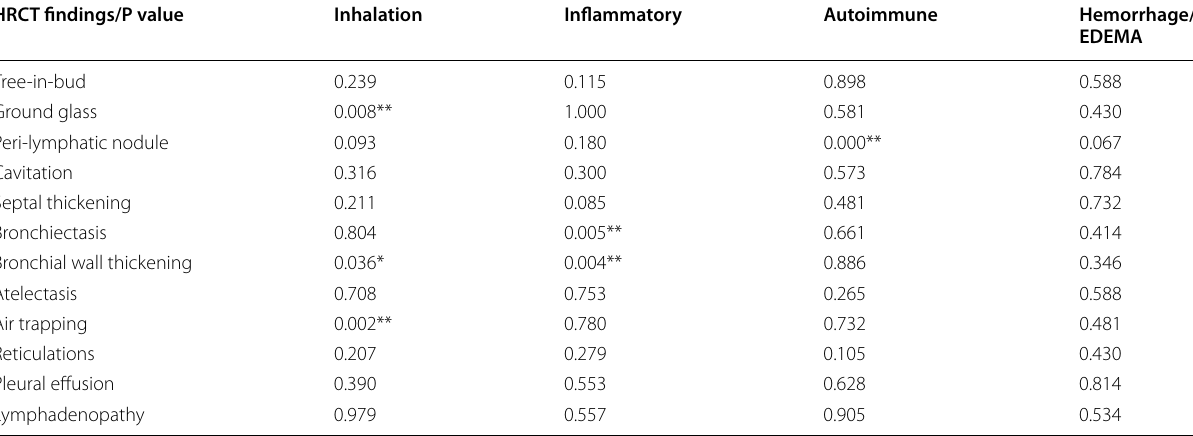
Table 3 The significance of inhalation, inflammatory, autoimmune and edema/hemorrhagic lung diseases regarding the associated CT chest